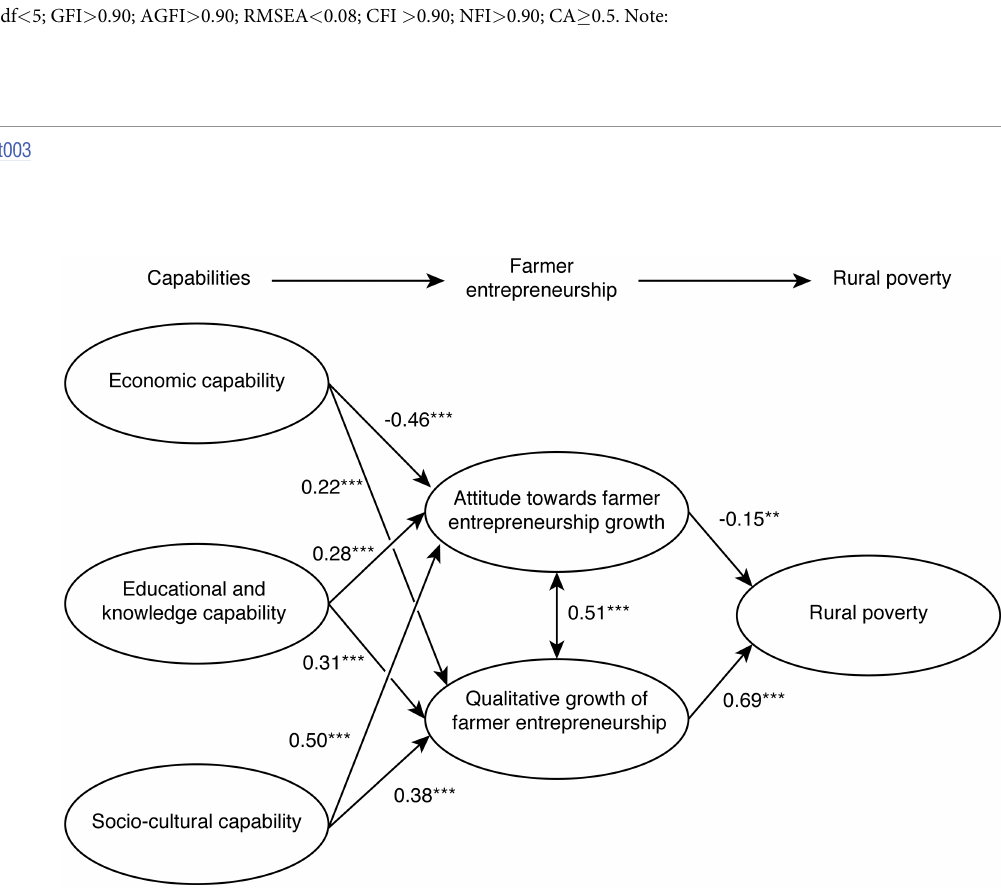
Fig 1. Structural equation model with standardized path